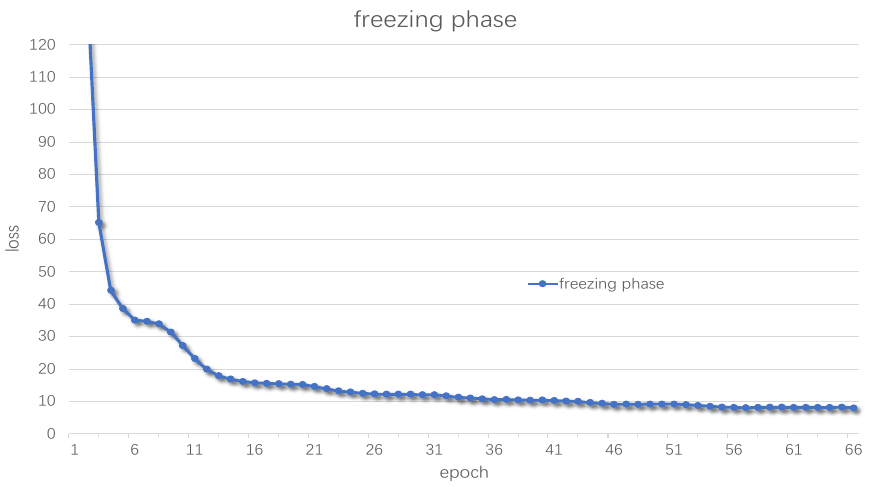
Figure 8. Loss change in un freezing phase. 4.3. Experiment Results In order to further test the performance of the improved algorithm in this paper, three sets of comparative experiments will be conducted, and each set of comparative experiments will use the same training set and test set, the same training strategy and the same evaluation criteria to ensure the validity of the test results. The first set of ex- periments compares the improved YOLOv4 algorithm proposed in this paper with the current mainstream object detection algorithms such as YOLOv4, YOLOv3, Faster RCNN, etc. The experiment result is shown in Table 2.